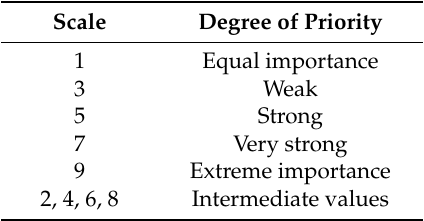
Figure 1. Hierarchy process according to the proposed attributes. Table 1. Nine-point scale used in pairwise comparison [38].